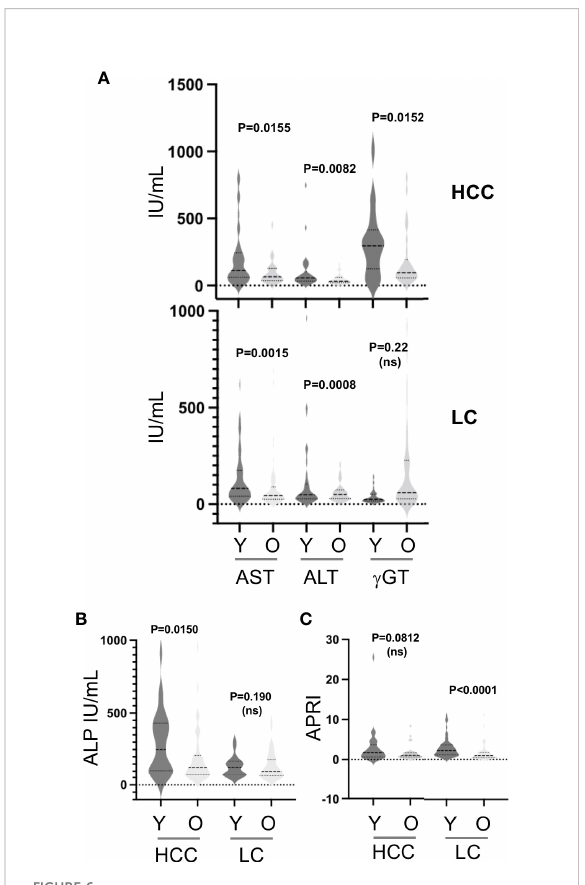
FIGURE 6 (A) , Serum concentrations of aminotransferases (ALT, AST) and gamma-glutamyl-transferase (GGT) in HCC and LC according to the median for age of each group. (B) , Serum concentrations of alkaline phosphatases (ALP) in LC and LC according to the median for age. (C) , Calculated ALT-to-Platelets Ratio Index (APRI) in HCC and LC according to the median for